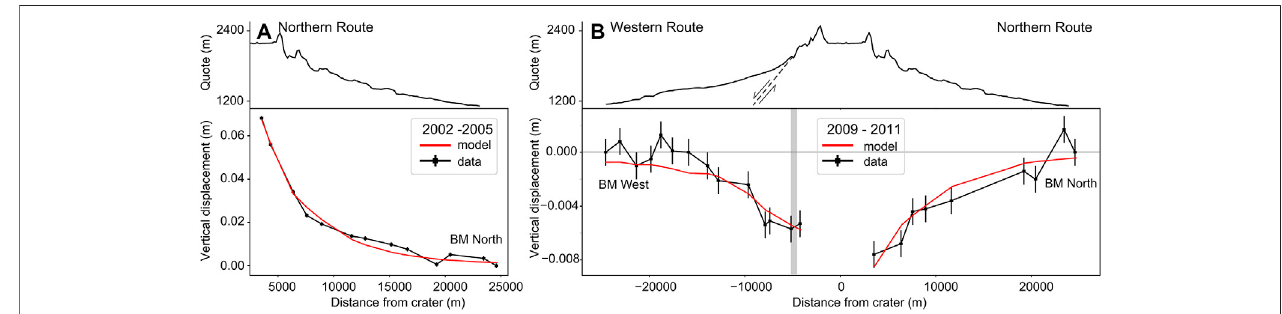
FIGURE 4 | (A) Elevation changes along the northern leveling route during the 2002 – 2005 unrest and (B) height changes along the northern and western routes during the subsidence 2009 – 2011 (leveling routes reported in Figure 2 ). The vertical bars on data points are the uncertainty associated with the leveling data. The grey vertical bar is the approximate location of the NW-SE trending fault trace located in the western fl ank of the volcano. Leveling data redrawn from Xu et al. (2012). On the top is reported the topographic pro fi le along the leveling routes. The dashed line is the NW-SE fault seen in a section across the volcano edi fi ce.